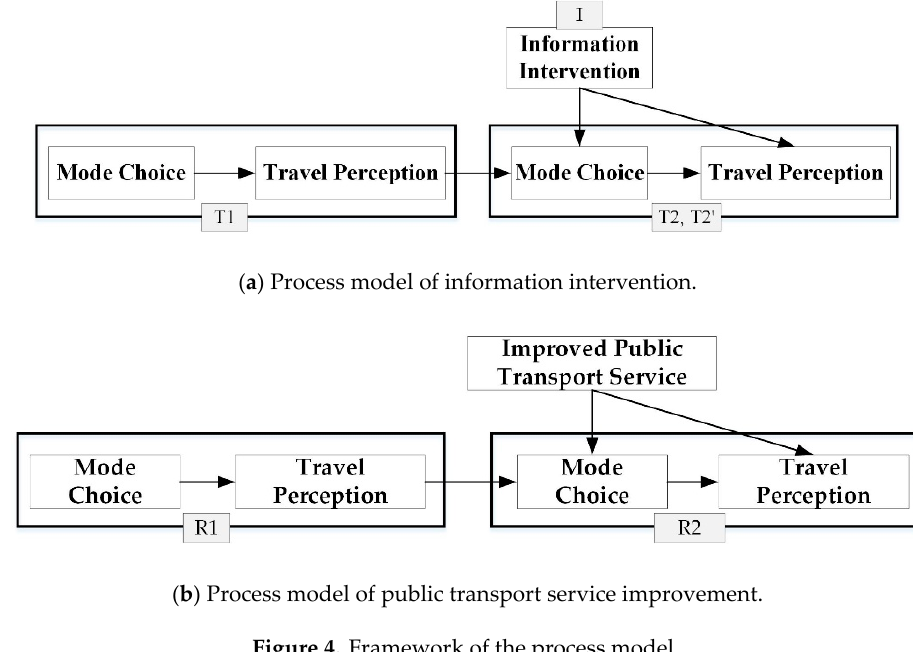
Figure 4. Framework of the process model.